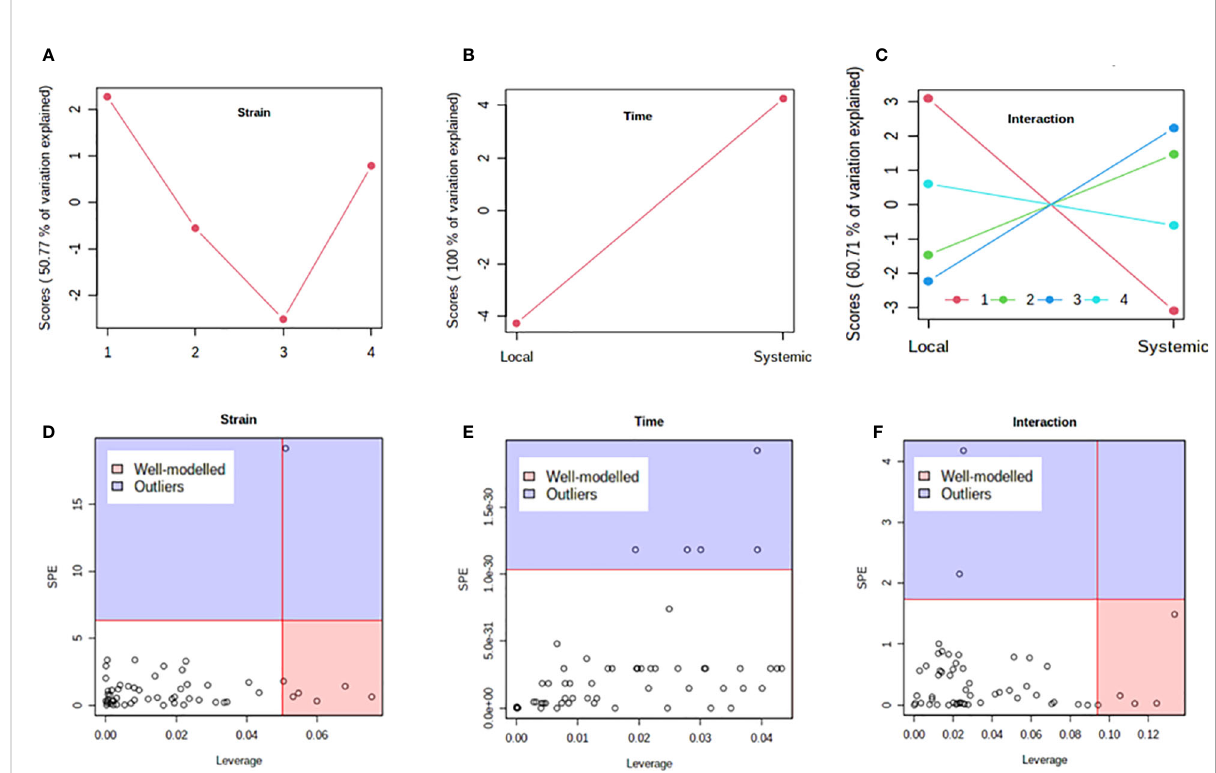
FIGURE 4 Analysis of variance – simultaneous component analysis (ASCA or ANOVA – SCA) of the differential host response to potato virus Y (PVY) infection of Premier Russet. (A – C) ASCA score plots showing the major patterns associated with strain, time, and their interaction; Plot legend for C: 1=mock, 2=PVY O , 3=PVY N-Wi , 4= PVY NTN . (D – F) ASCA selection of important variables (metabolites) associated with strain, time, and their interaction by leverage/squared prediction error (SPE) analysis. Vertical and horizontal lines indicate cut-off leverage and SPE values, respectively. Metabolites with a high leverage value and a low SPE value were considered to be differential metabolites (the well-modeled group). Metabolites in blue have patterns that are different from the major patterns. The list of well-modeled metabolites is given in Supplementary Table